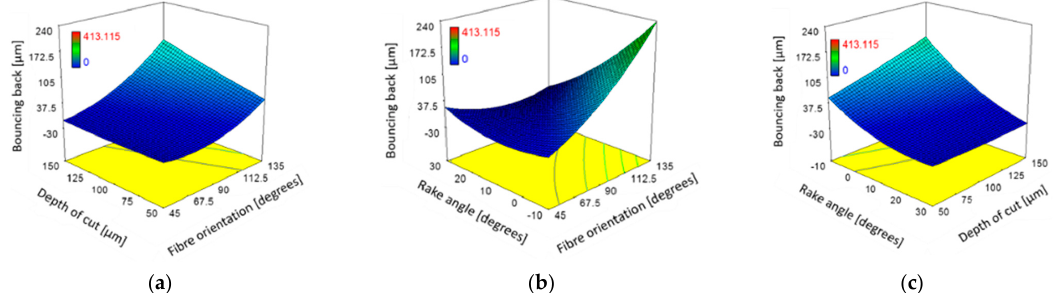
Figure 23. The combined effect on bounce back for ( a ) fibre orientation and cutting depth at constant α : 10°; V c : 570 mm/min; ( b ) fibre orientation and rake angle at constant DOC: 100 µm; V c : 570 mm/min; ( c ) rake angle and cutting depth of constant θ : 90°; V c : 570 mm/min.